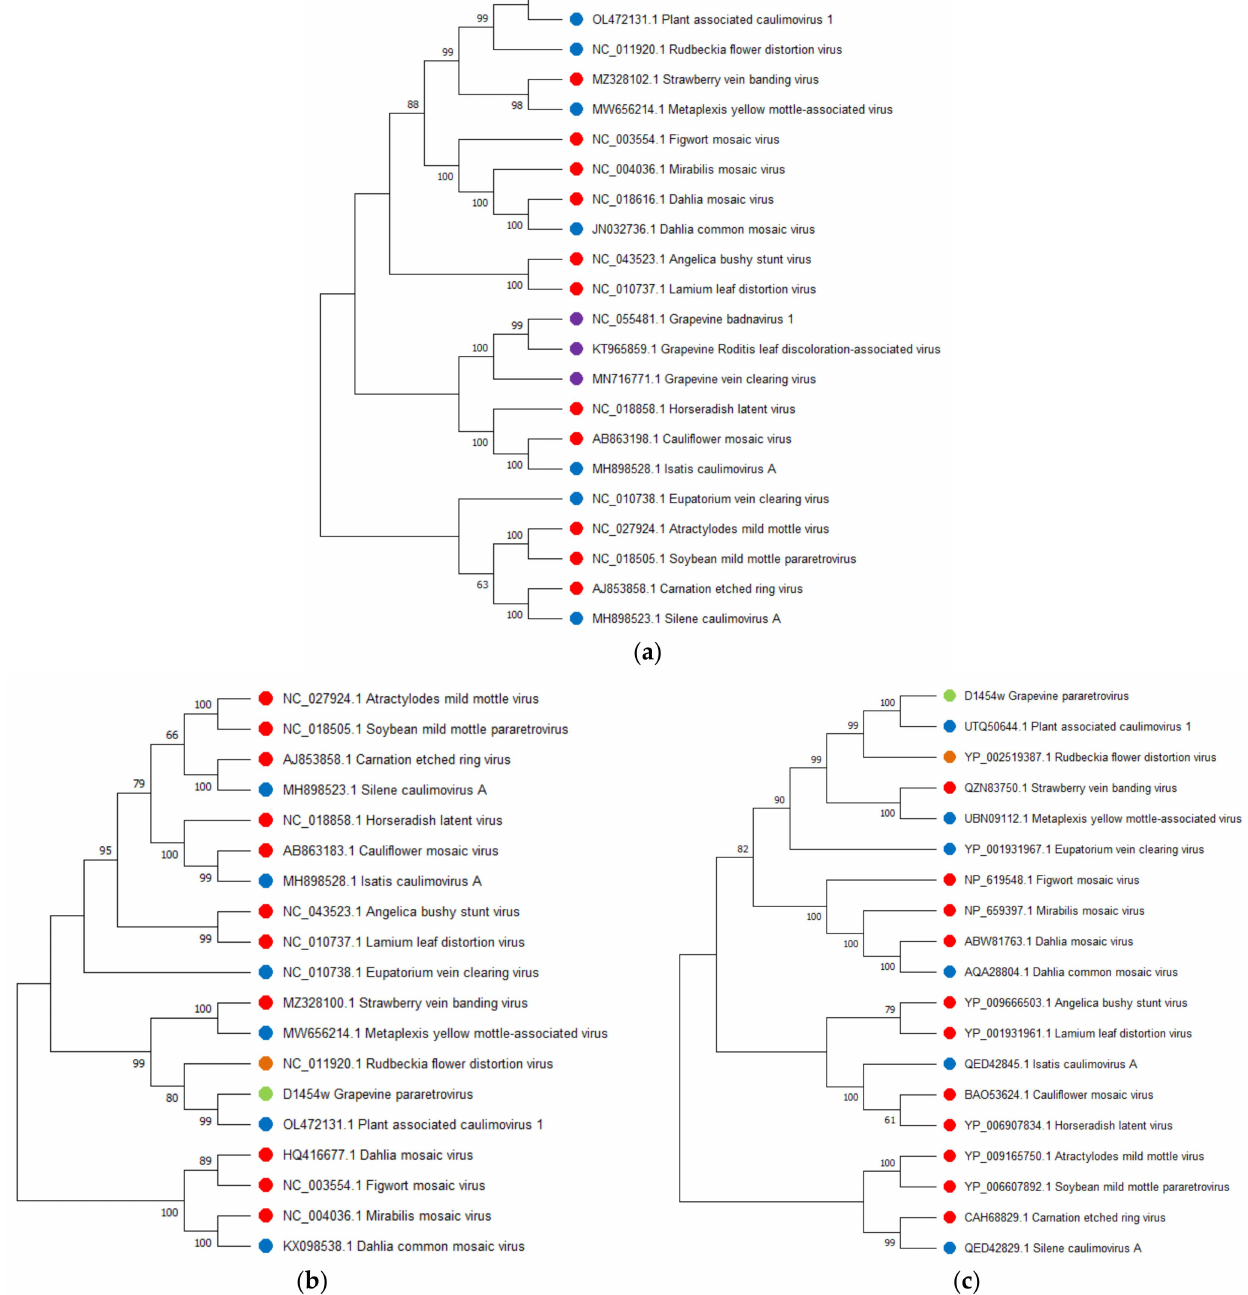
Figure 7. Phylogenetic analysis of ( a ) complete genomes, ( b ) nucleotide sequences of polymerase region and ( c ) amino acids sequences of polymerase region of grapevine pararetrovirus (marked with a green dot), representative isolates of the genera Ruflodivirus (marked with an orange dot), Caulimovirus (marked with a red dot), including unclassified Caulimovirus (marked with a blue dot), and Badnavirus (marked with a purple dot). The tree was constructed using the neighbor-joining method. The numbers at the nodes indicate bootstrap values >60% (1000 replicates). GenBank accession numbers for each isolate are present by virus isolate names and are also in Supplementary Table